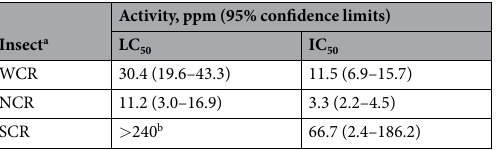
Table 1. Potency of AfIP-1A/1B against Diabrotica corn pests in artificial diet bioassay. AfIP-1A and AfIP-1B were assayed at a 1:1 ratio with values representing combined mass of both components. a WCR, western